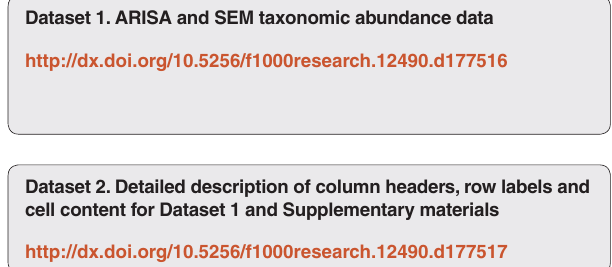
Dataset 2. Detailed description of column headers, row labels and cell content for Dataset 1 and Supplementary